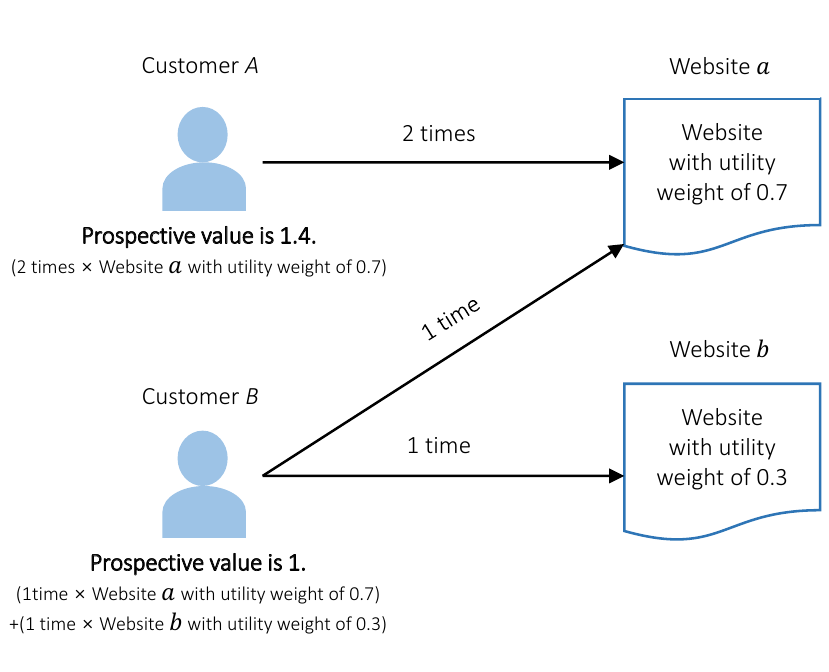
Figure 2. Example of the difference in the website pages accessed by customers